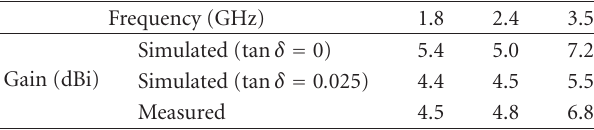
Table 1: The simulated and experimental results of the printed Yagi-Uda antenna unit